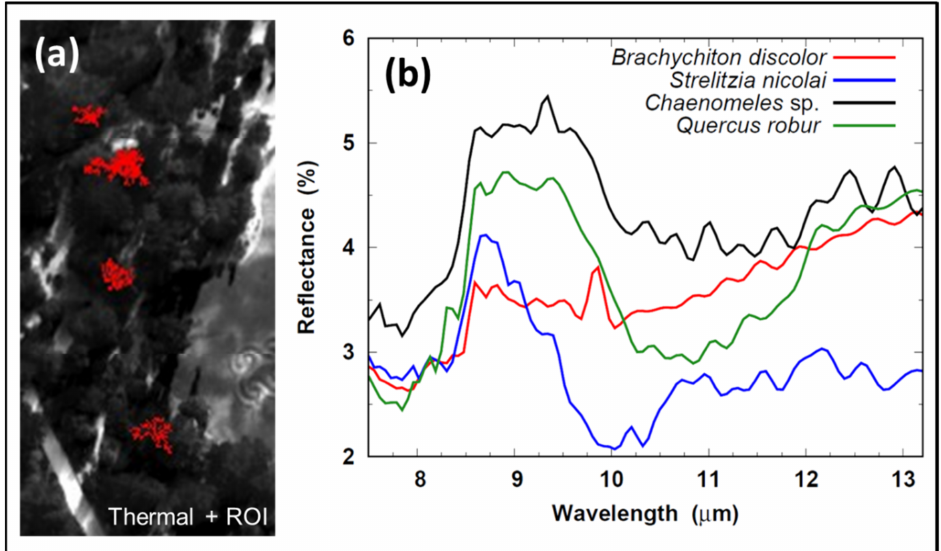
Figure 23. ( a ) Series of Brachychiton discolor ROIs; ( b ) spectral intercomparison between the four unrelated species that deliver competing